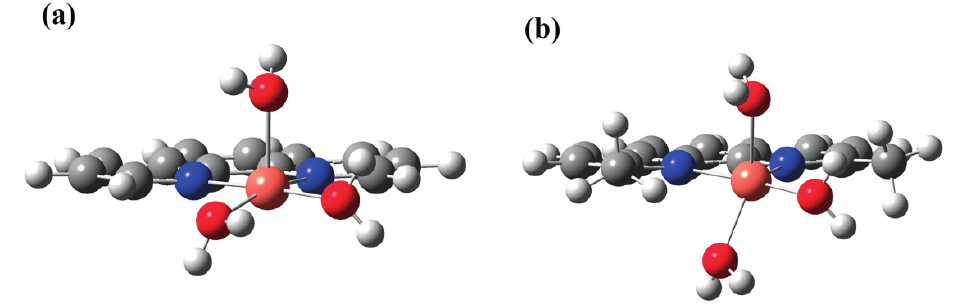
Figure 6. Optimized structure of ( a ) [Cu(phen)(H 2 O) 3 ] 2+ and ( b ) [Cu(2,9-dmp)(H 2 O) 3 ] 2+ . The color of the atoms: orange, Cu; blue, N; red, O; gray, C; white, H. The intercalated form of [Cu(2,9-dmp)(H 2 O) 3 ] 2+ shown in Figure S6a is obtained by